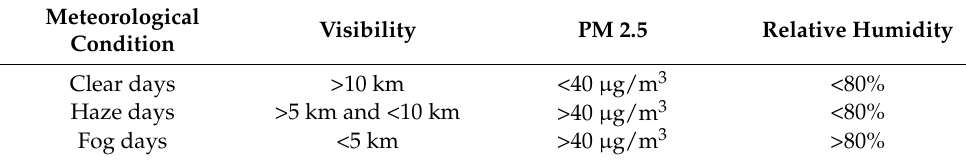
Table 2. Statistics of meteorological parameters in different conditions.